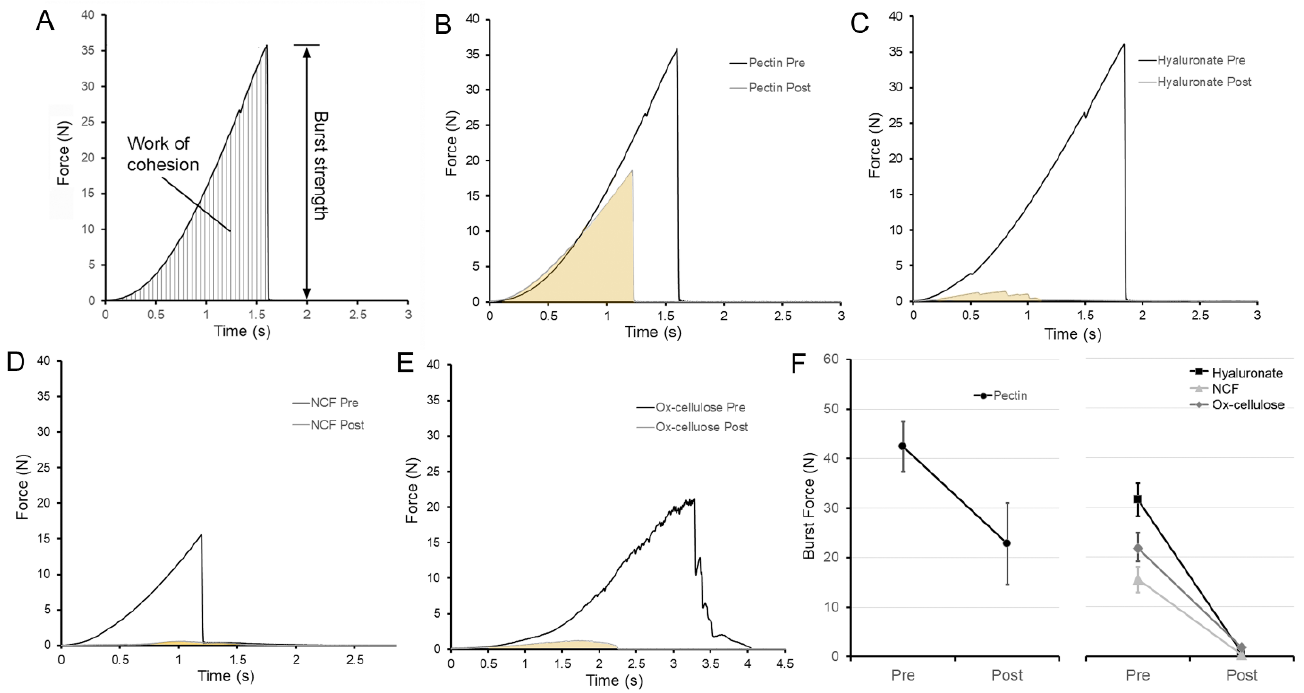
Figure 4. Burst strength and fracture mechanics of pectin films before and after water repair. ( A ) Using a spherical stainless-steel probe (5 mm), the pectin films were loaded (2 mm/s) until fracture. The peak force was recorded as burst strength. After fracture of the film, water-induced repair was followed by repeat fracture of the film. ( B ) Characteristic burst force curves of pectin films are shown before (black) and after (gray) burst fracture and water-induced repair. Burst strength curves are also shown for sodium hyaluronate ( C ), NCF ( D ), and ox-cellulose ( E ). ( F ) Summary of burst strength replicates (N = 10). Pectin burst strength after repair was significantly greater than the three controls ( p < 0.001). The mean ± 1 standard deviation (SD) is shown. The fracture mechanics were assessed at a water content of 8% ( w / w ).